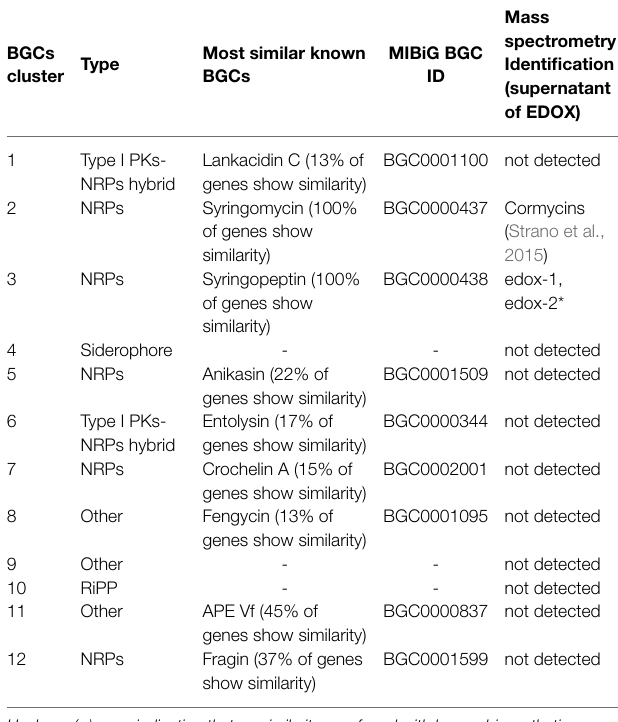
TABLE 2 | Secondary metabolite and antibiotic gene clusters identified from P. mediterranea EDOX using antiSMASH 6.0 and